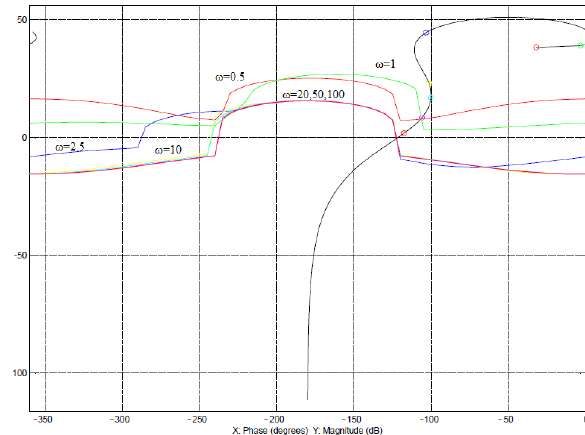
Figure 9. The boundary of the plant template for the vertical plane